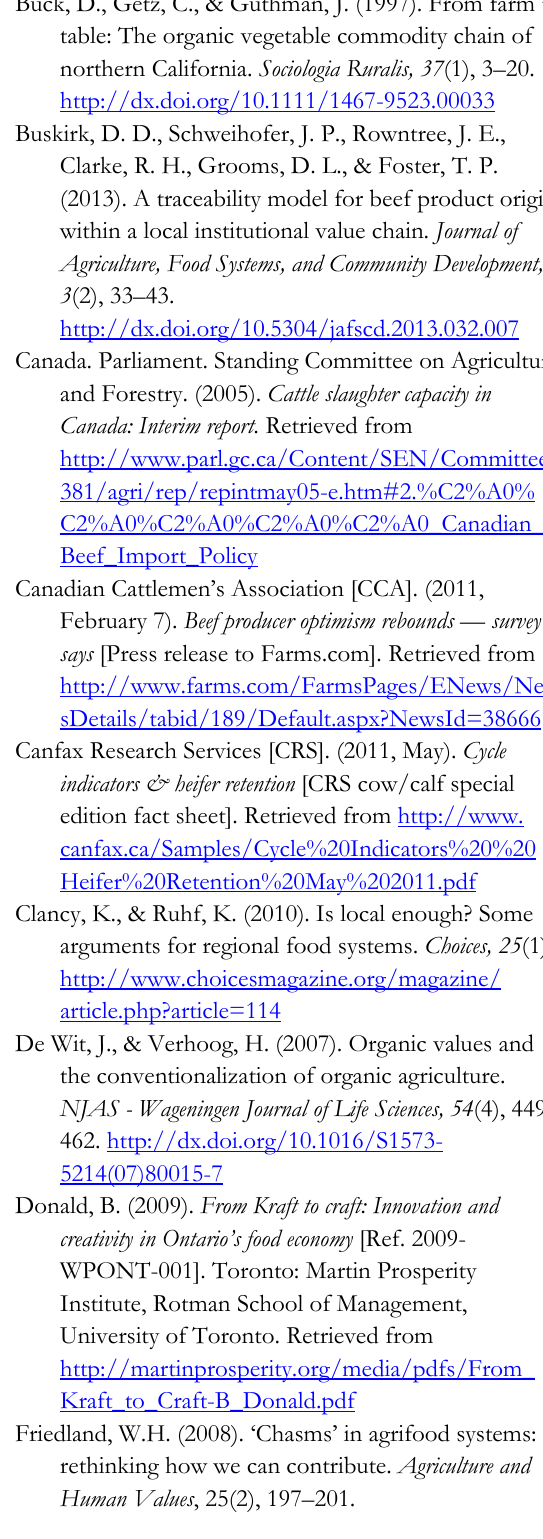
table: The organic vegetable commodity chain